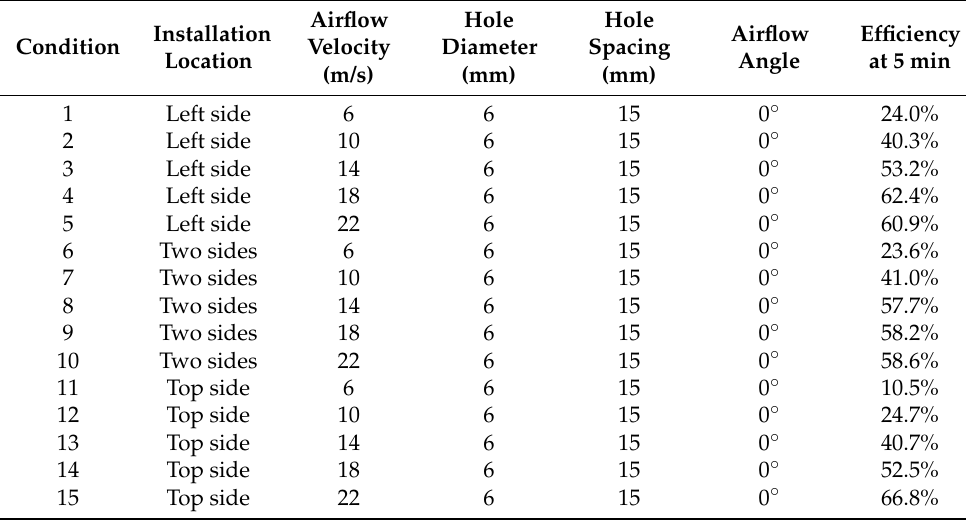
Table 1. The barrier efficiency of pipeline air curtain at 5 min in 33 kinds of conditions.